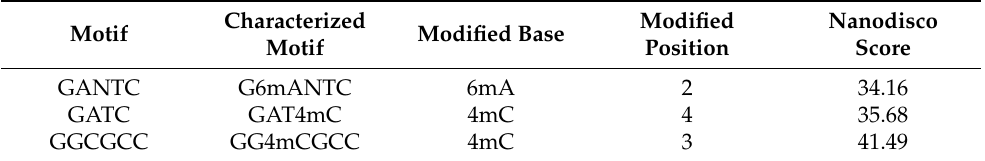
Figure 1. The coverage plots for the genome in two conditions. The plots represent the coverage statistics across the replicons. Table 2. Motif distribution by replicon.